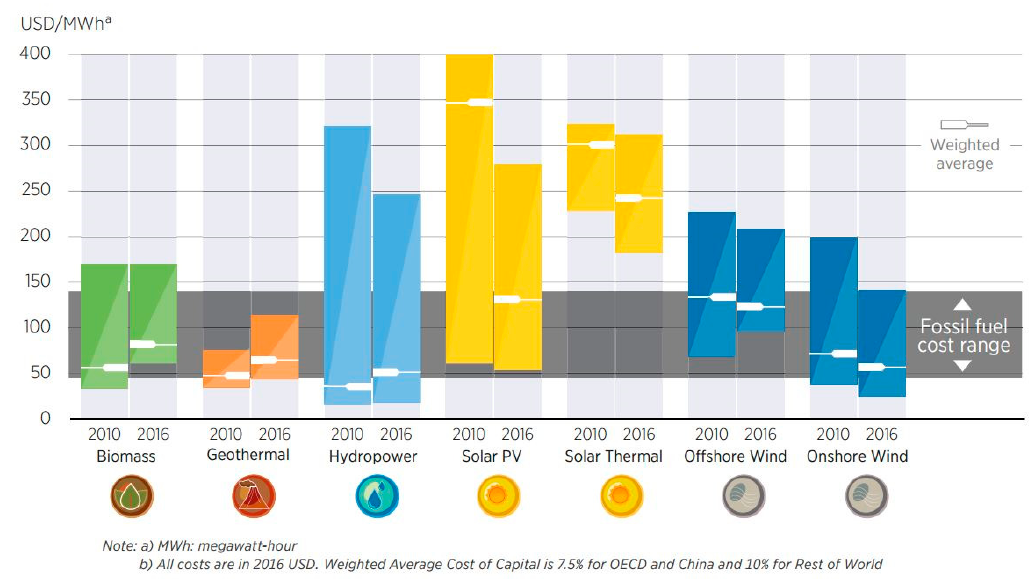
Figure 6. Levelized cost of electricity (LCOE) in 2010 and 2016 [19].